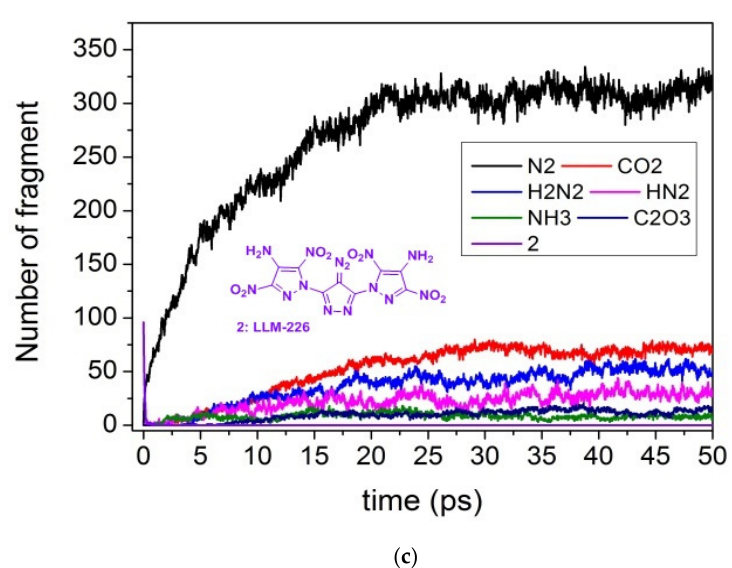
Figure 8. Evolution of key chemical species of LLM-226 (2) at 1500 K ( a ), 2000 K ( b ) and 3000 K ( c ).